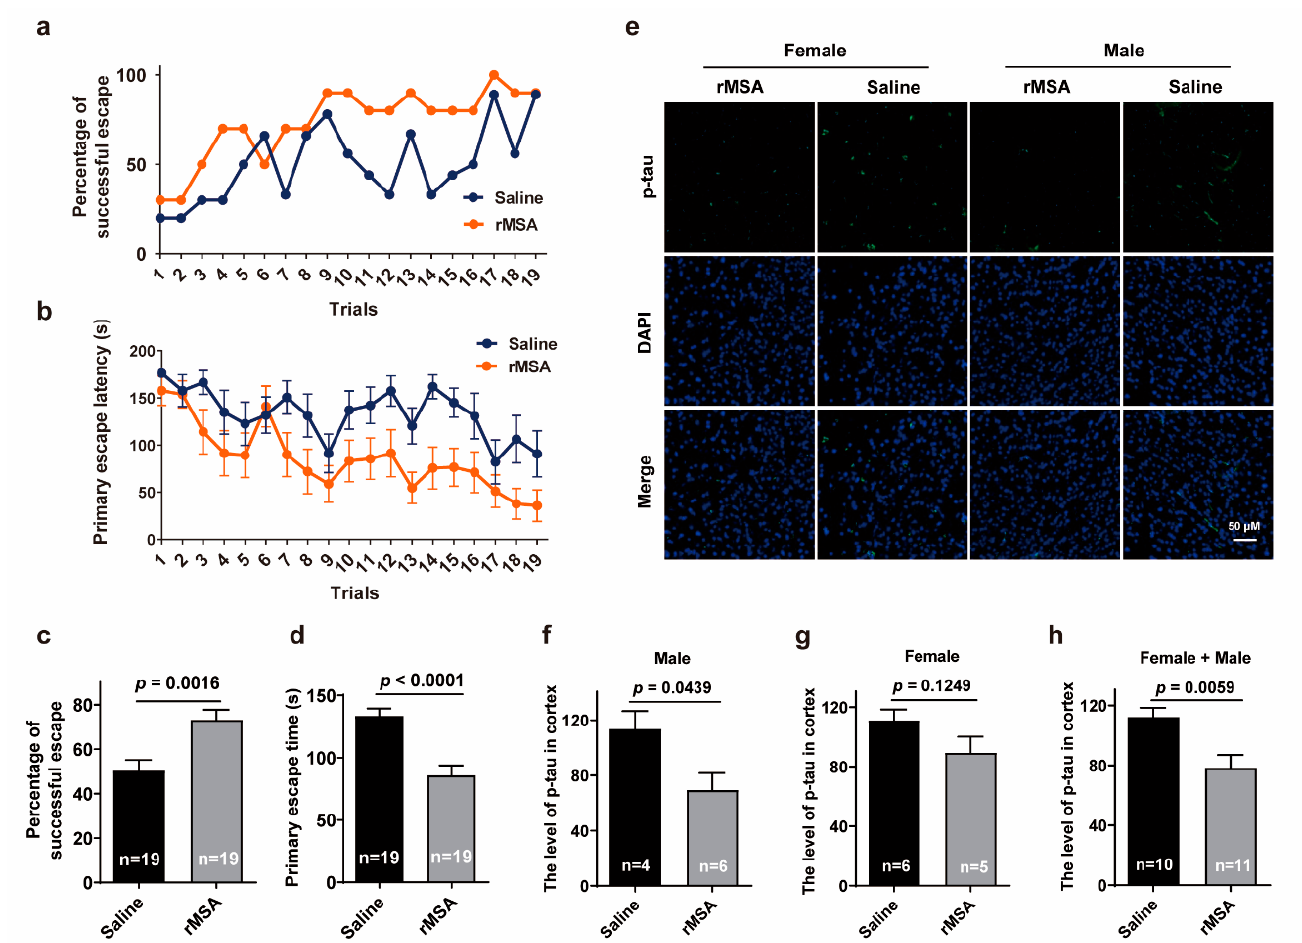
Figure 3. Effects of rMSA on the spatial learning and memory of mice. ( a , b ) Measurements of the percentage of successful escape ( a ) and the primary escape latency ( b ) of male mice. ( c ) The average of ( a ). n, the number of trials. ( d ) The average of ( b ). n, the number of trials. ( e ) The representative images of p-tau in the mice cortex. Scale bar, 50 µ m. ( f – h ) The quantitative results of p-tau (green) and DAPI (blue) in male ( f ), female ( g ) and female + male ( h ) mice. n, the number of mice used for analysis. Mice were treated with rMSA 1.5 mg per gram of body weight or isometric saline every 3 weeks for 8 months. All graphs represent mean with SEM, with p values calculated by the two-tail t test.